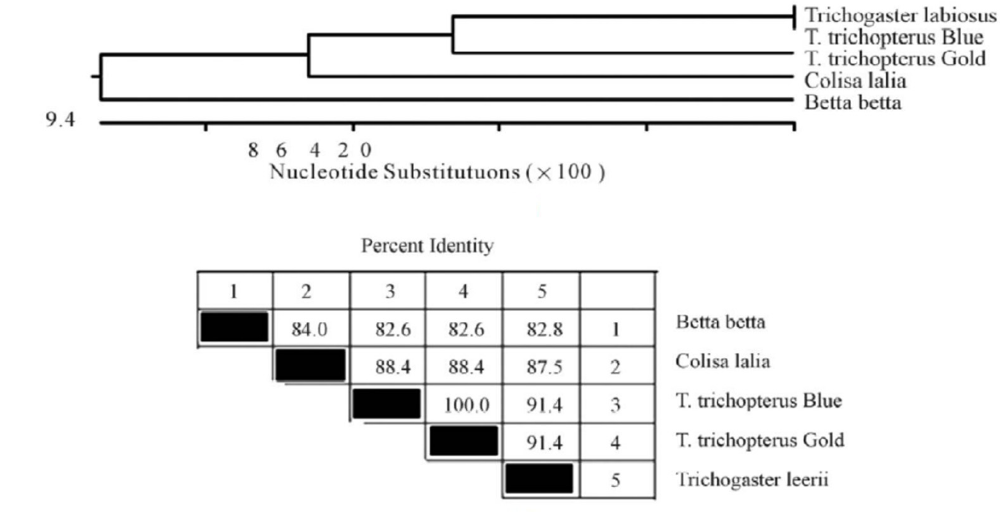
Figure 8. Phylogenetic tree of the cytochrome b fragment based on nucleotide sequences of various fish species. The length of each pair of branches represents the distance between sequence pairs, while the units at the bottom of the tree indicate the number of substitution events. The phylogenetic tree was constructed by Clustal W and analysis alignment in the MegAlign program (DNASTAR). Percent DNA sequence identities are also shown [2].